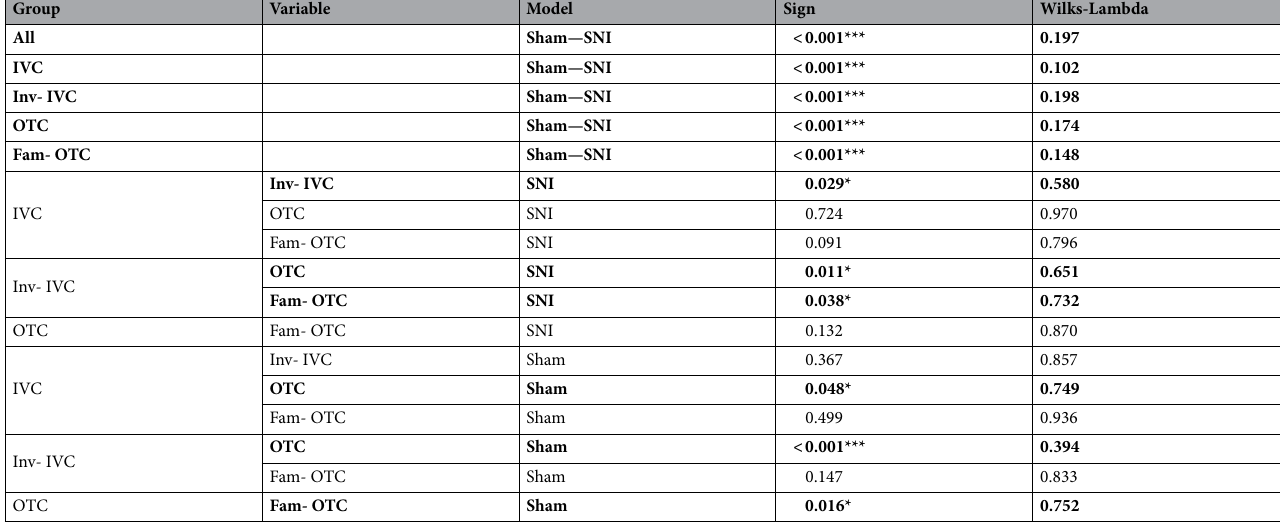
Table 1. Results of multivariate analysis of variance (MANOVA) in Fig. 1h,I. Significant values are in